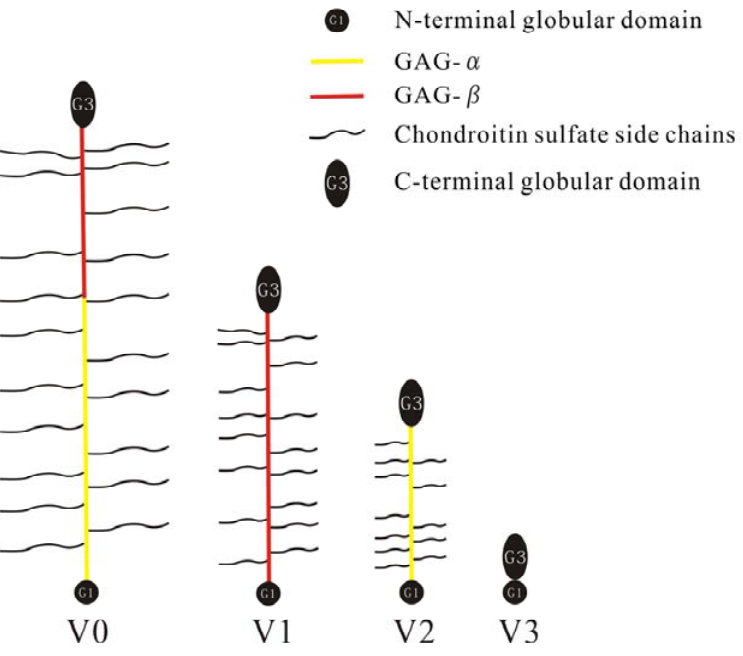
Figure 1. Schematic diagram of versican